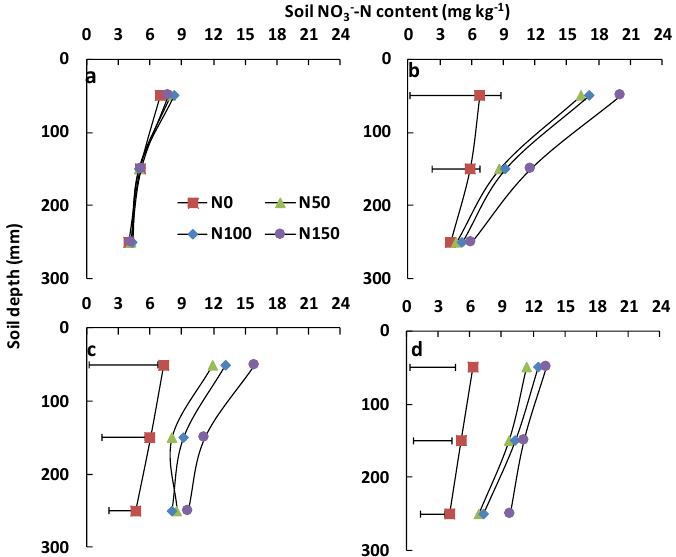
Figure 3. 0–300 mm soil NO 3 − -N content from four nitrogen addition treatments before first ( a ), second fertilize ( b ), beginning ( c ) and end of experiment ( d ). The error bar indicated the least significant difference (LSD) (p = 0.05) of soil NO 3 − -N content between four nitrogen levels at each layer, n = 3.